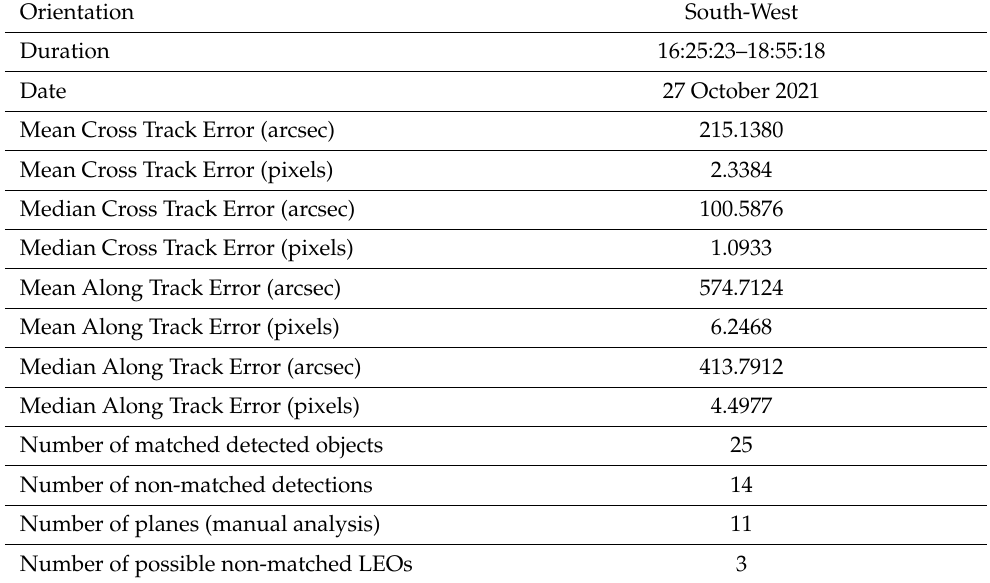
Table 1. Error statistics for the SW sequence.